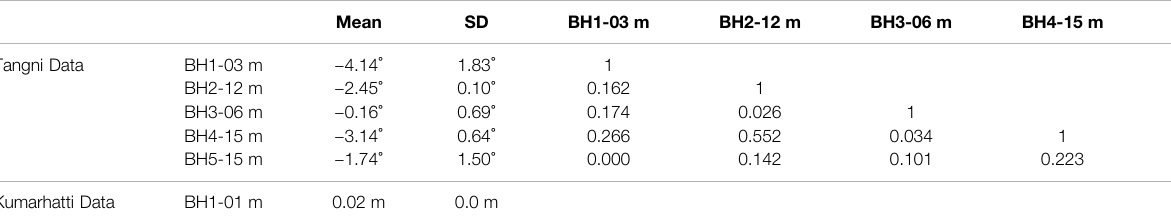
TABLE 1 | Means, standard deviations, and the correlations between the time series of different